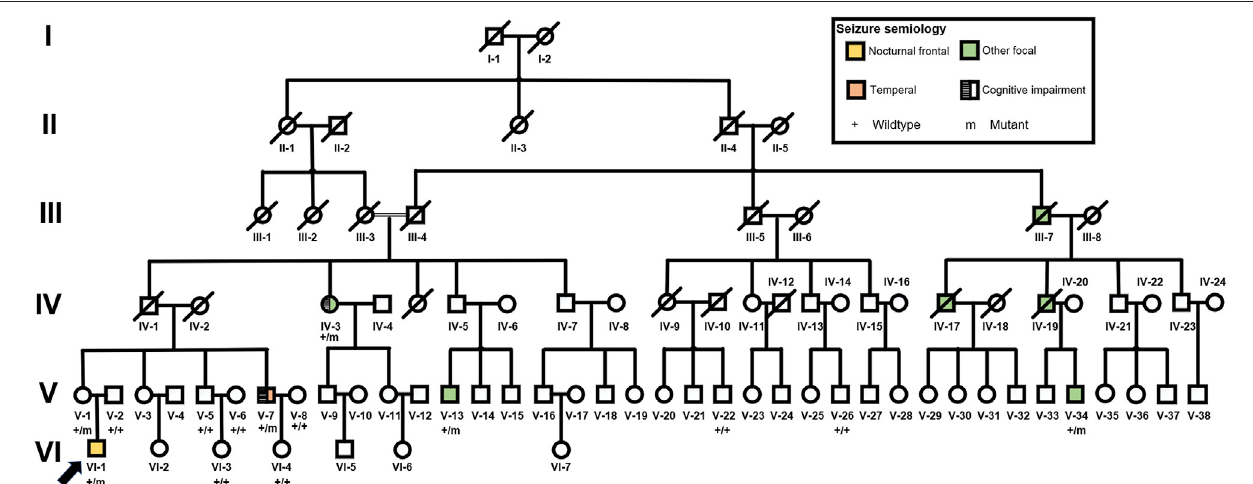
FIGURE 1 | Pedigree of the FFEVF with the NPRL3 p . Gln106*